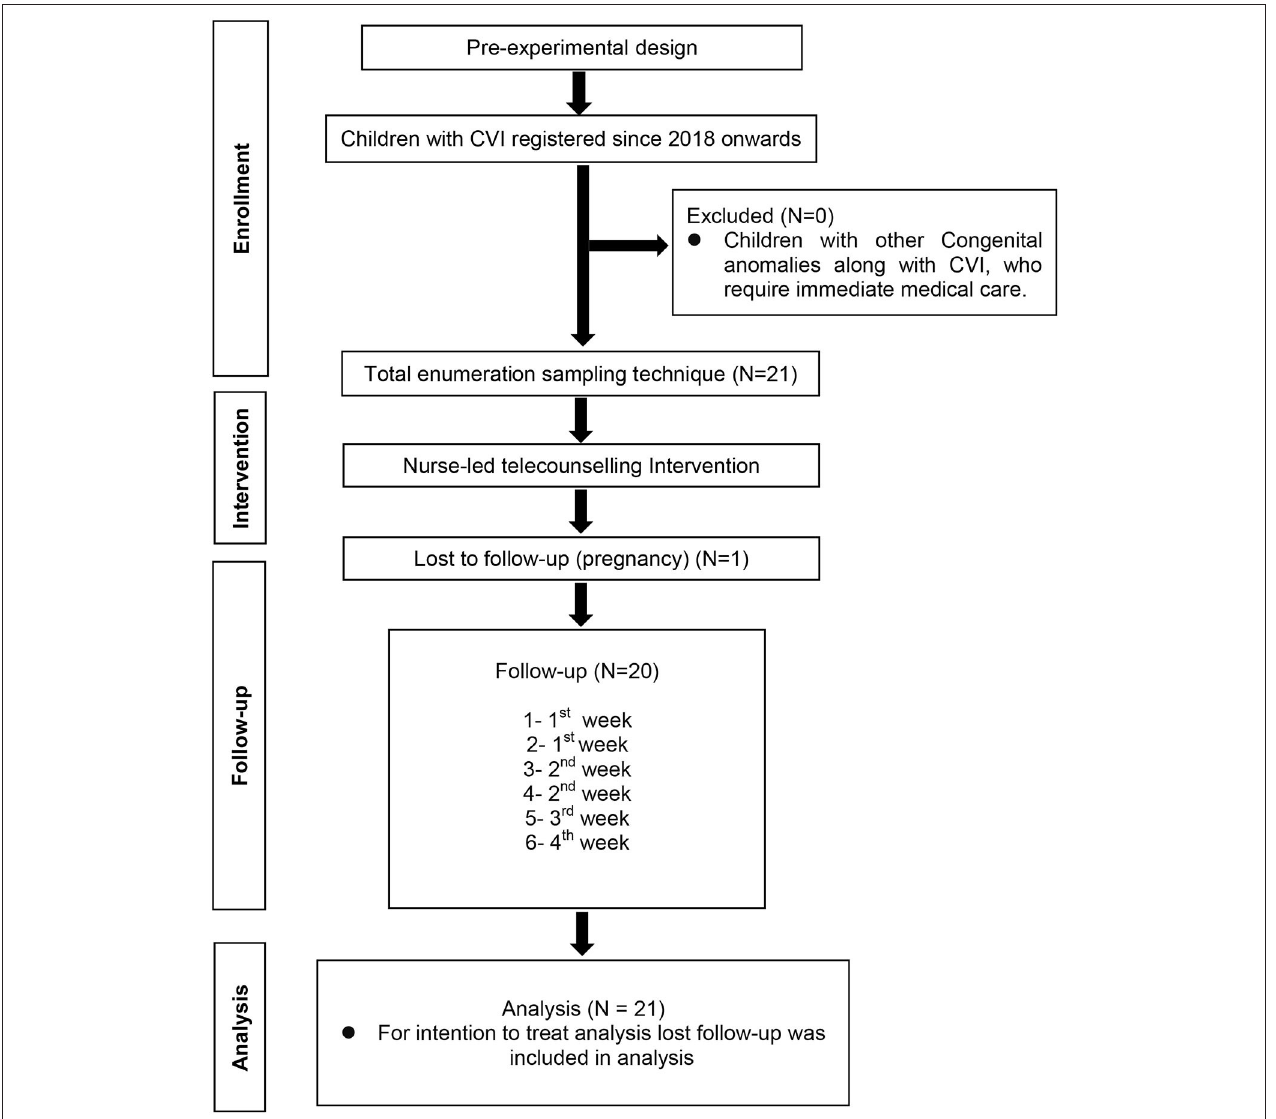
FIGURE 1 | Consort